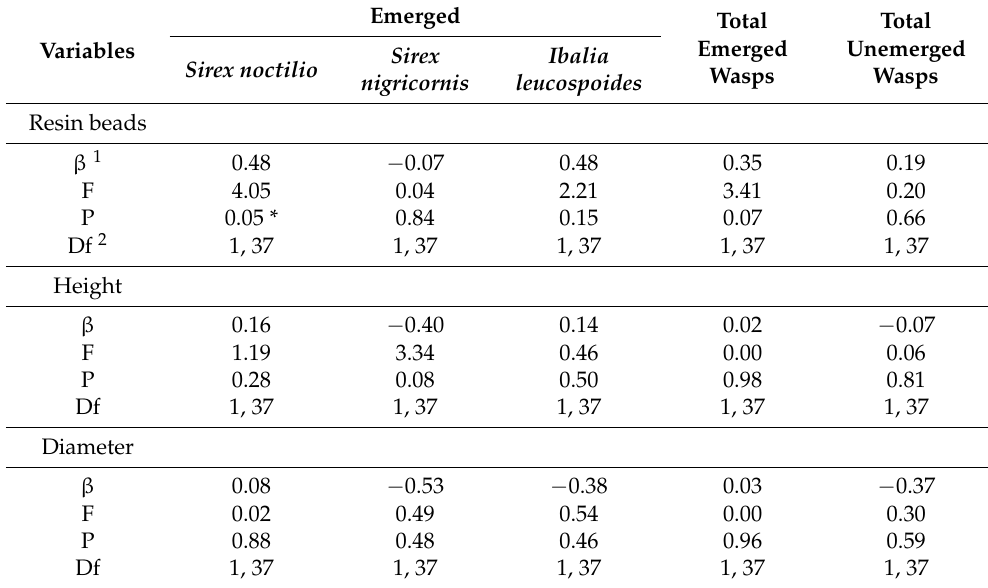
Table 1. Results of Generalized Linear Mixed Model analysis for the wood borer wasps.